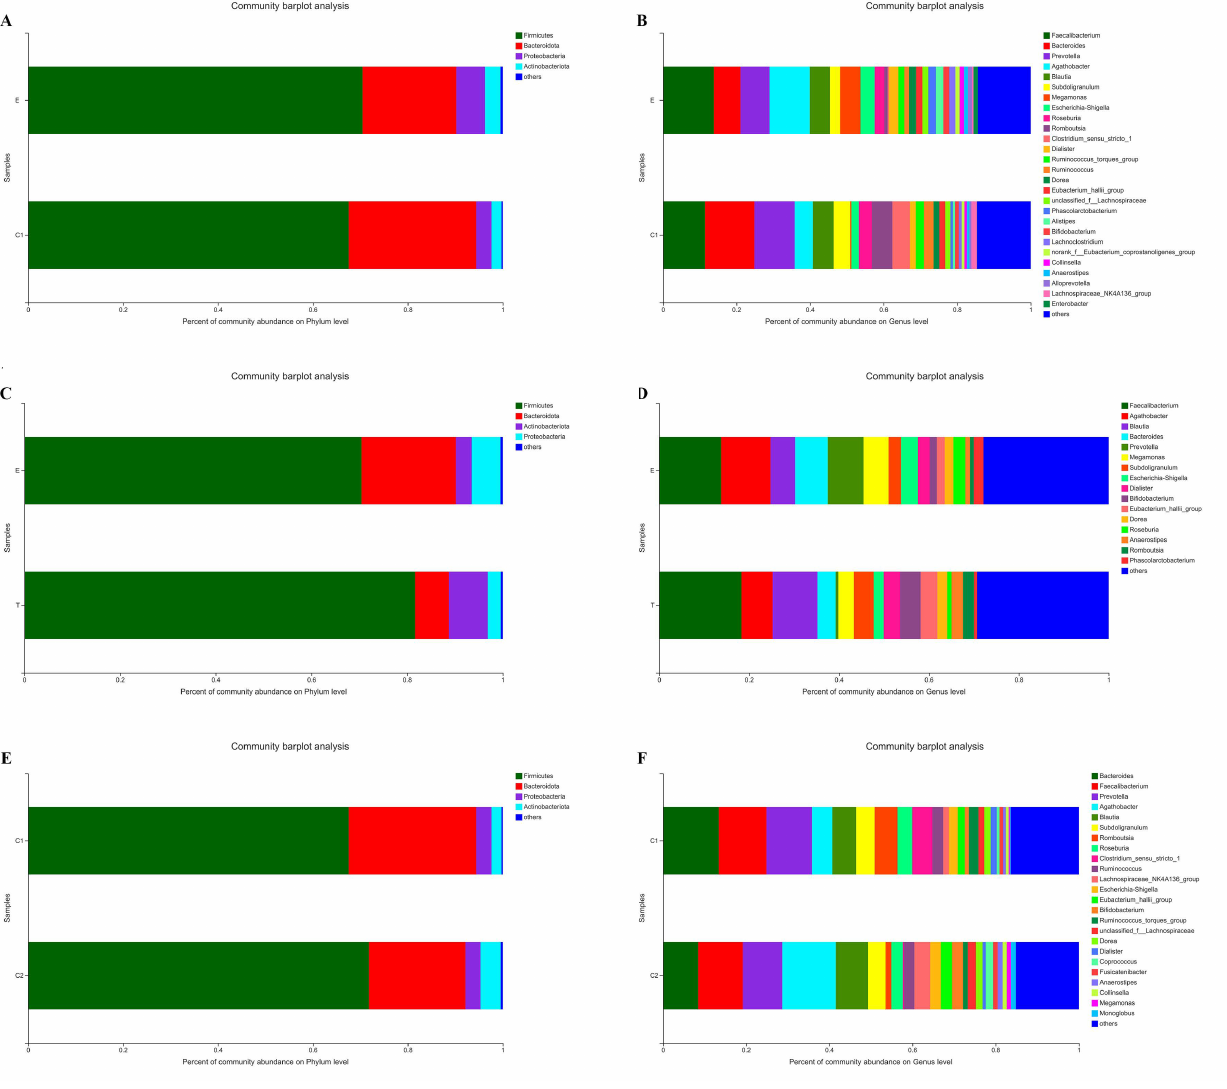
Figure 1. Comparisons of the intestinal microbiome composition in different groups before and after exercise intervention. ( A , C , E ) The relative abundance of each phylum in each group. ( B , D , F ) The rela- tive abundance of each genus in each group. Different colors represent different phyla or genera. E: the experimental group before exercise intervention; T: the experimental group after exercise intervention; C1: the control group before exercise intervention; C2: the control group after exercise